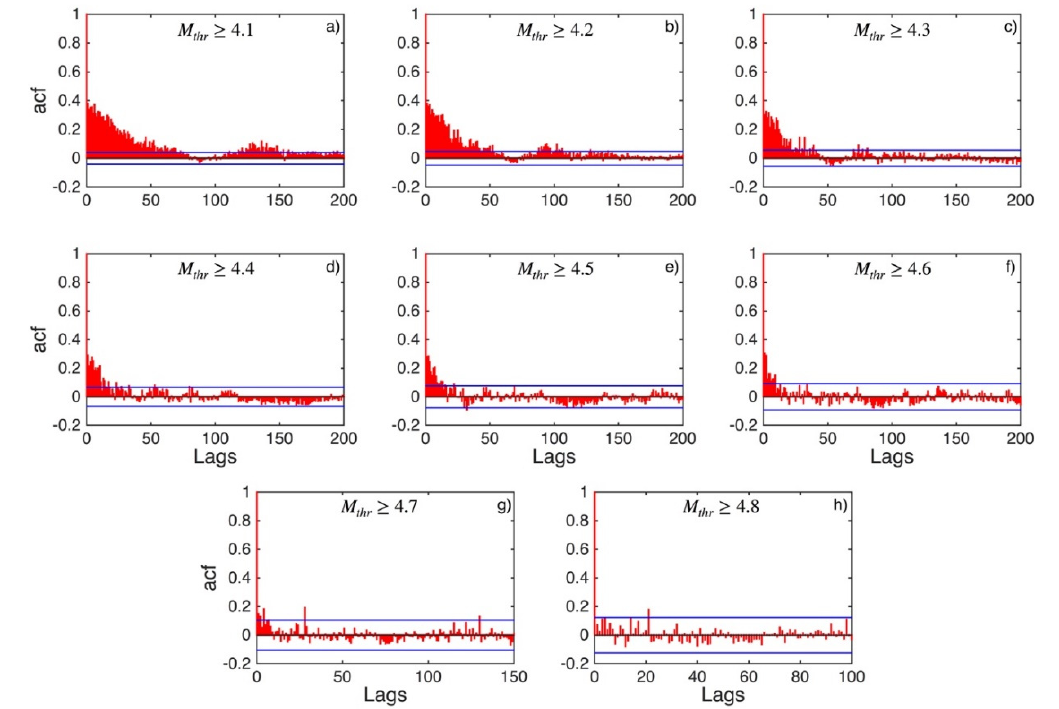
Figure A4. ACF values (red stems) and their 95% confidence intervals (blue lines) for Western Hellenic Arc (sub − area 3) for magnitude thresholds ( M thr ) varying from 4.1 to 4.8 (subplots a – h ).